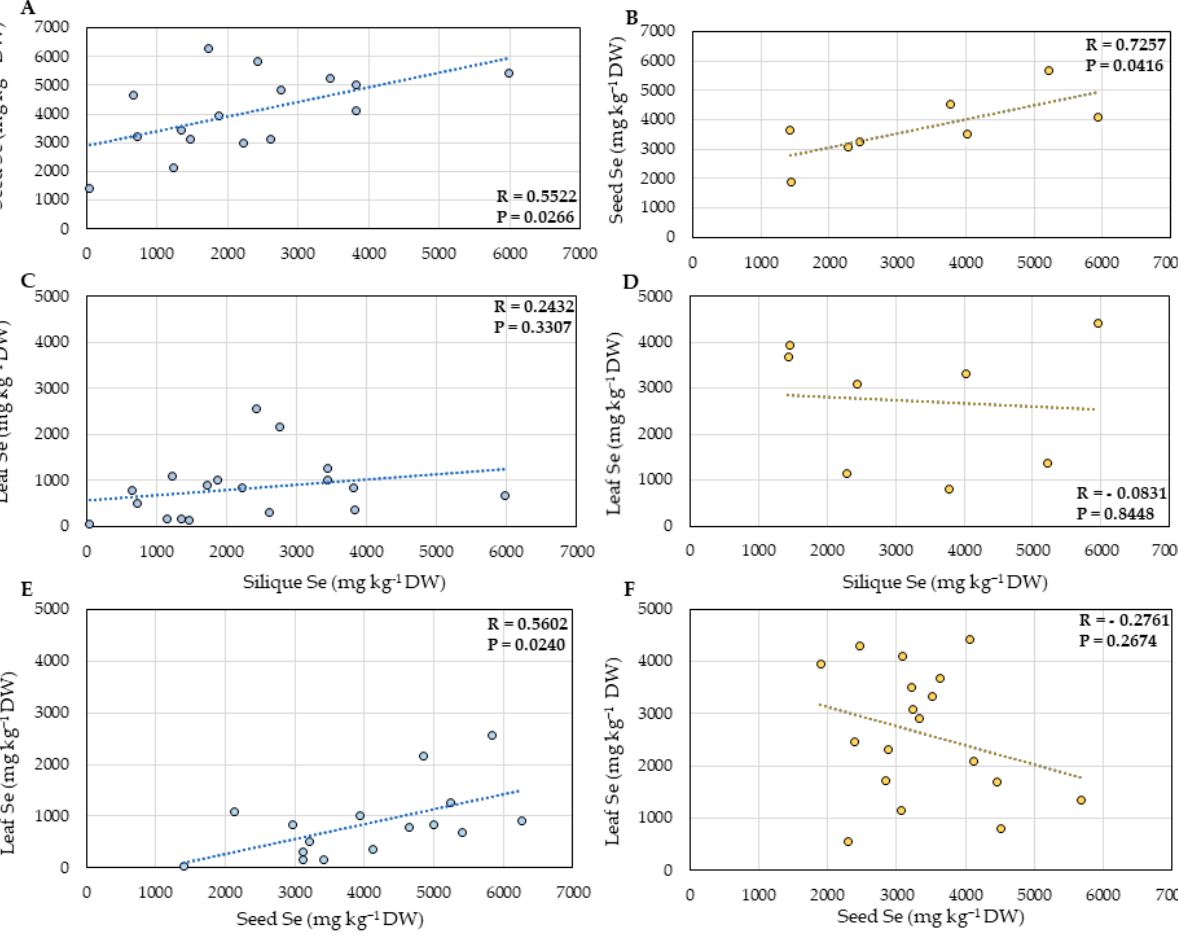
Figure 4. Correlation between seed and silique Se concentration ( A , B ), leaf and silique Se concen- tration ( C , D ), and leaf and seed Se concentration ( E , F ). Correlation coefficient R and p -value are shown in each panel. Panels ( A , C , E ) show the Coyote Ridge data. Panels ( B , D , F ) show the Pine Ridge